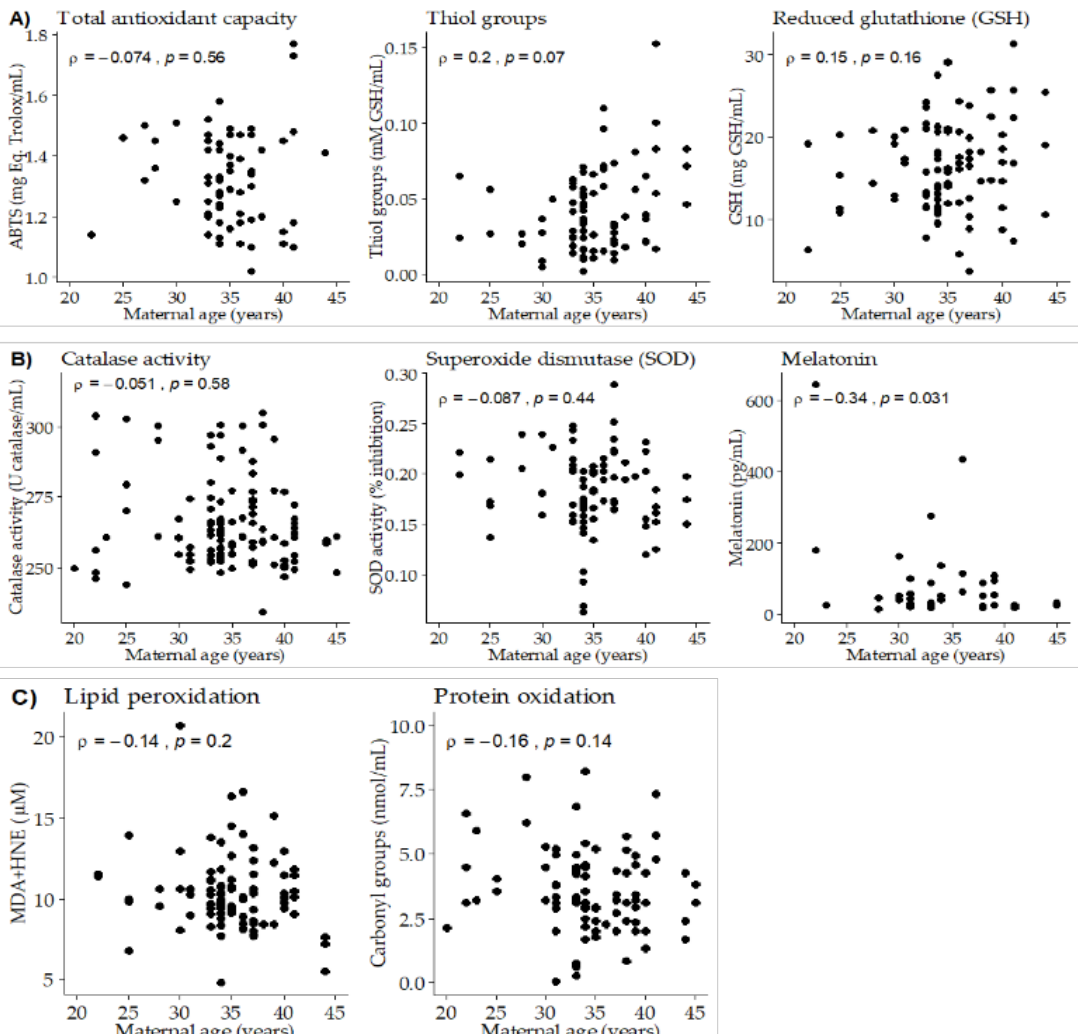
Figure 1. Scatter plots of breast milk antioxidants and oxidative damage biomarkers versus maternal age. ( A ) Total antioxidant capacity and low molecular weight antioxidants. ( B ) Antioxidant enzymes. ( C ) Oxidation biomarkers. Rho – Spearman test ( ρ ) and associated p -values are shown in each plot.